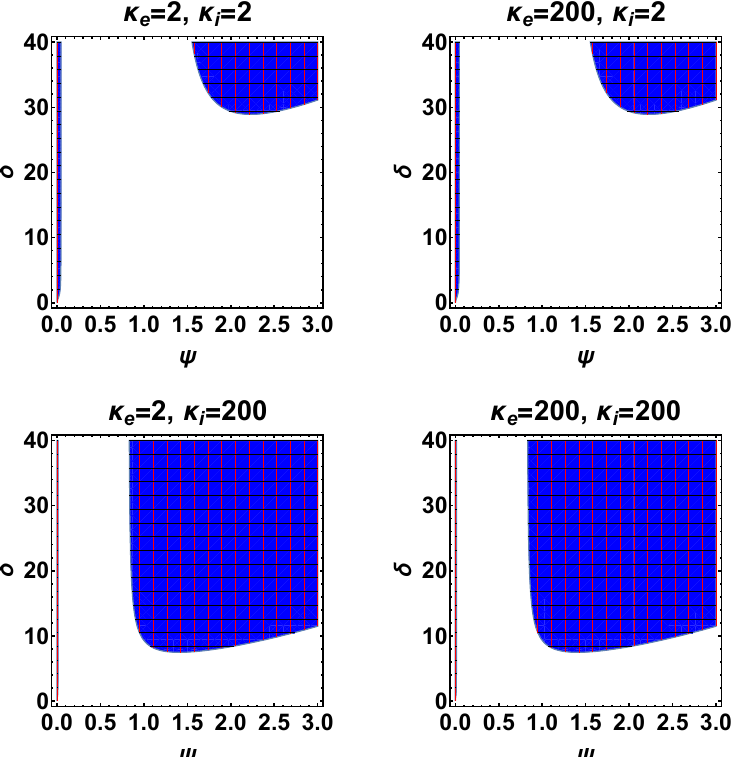
Figure 2. The width-amplitude relation for different configuration of ion and electron distribution function is shown for temperature ratio, T r = 3.